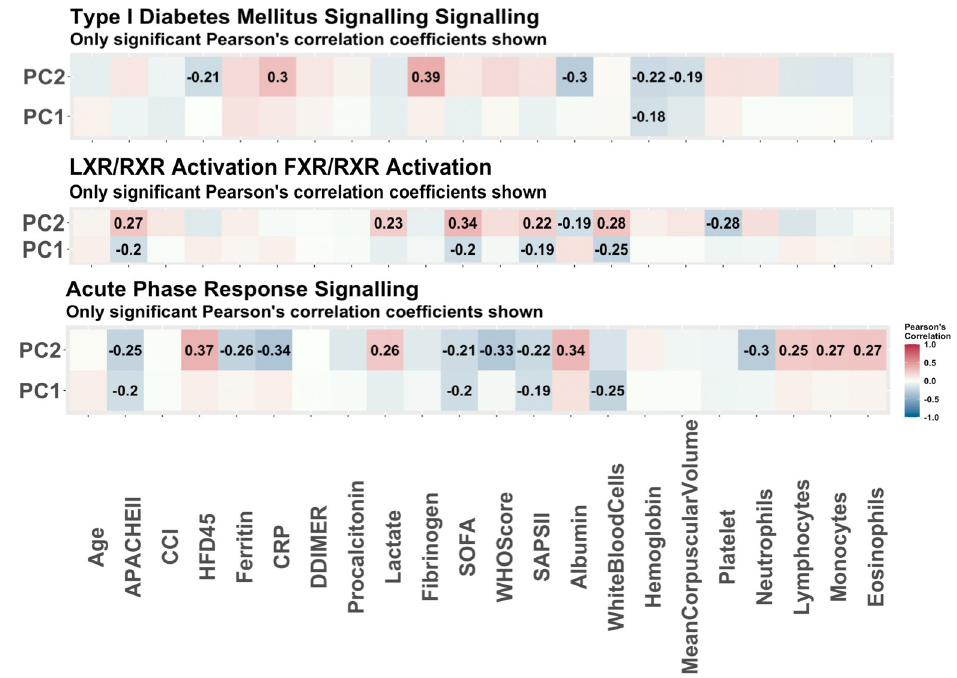
Fig 3. The Pearson correlations of principal components of pathways associated with disease status. The Pearson correlations of clinical variables and the principal components used to summarize the enriched pathways with COVID- 19 status as predicted by IPA. These are the pathways predicted to be enriched based on the 22 proteins determined to be associated with COVID-19 status via stability selection. Only the correlations which were significant (p-value < 0.05) are reported. The strongest correlations with the LXR/RXR activation and FXR/RXR activation pathways are with SOFA score and white blood cell count. The strongest correlation with the acute phase response signalling pathway is with HFD-45. With the diabetes mellitus signalling pathway, the top correlation is with fibrinogen.